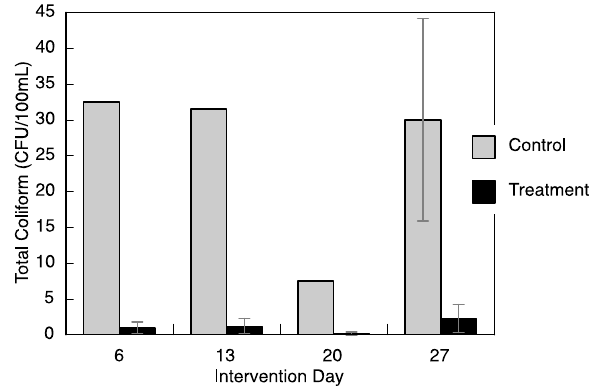
Figure 4. Performance results from the school study in community C. Measurements of total coliform from the control buckets that had no treatment (gray) and the average of the four treatment buckets (black).